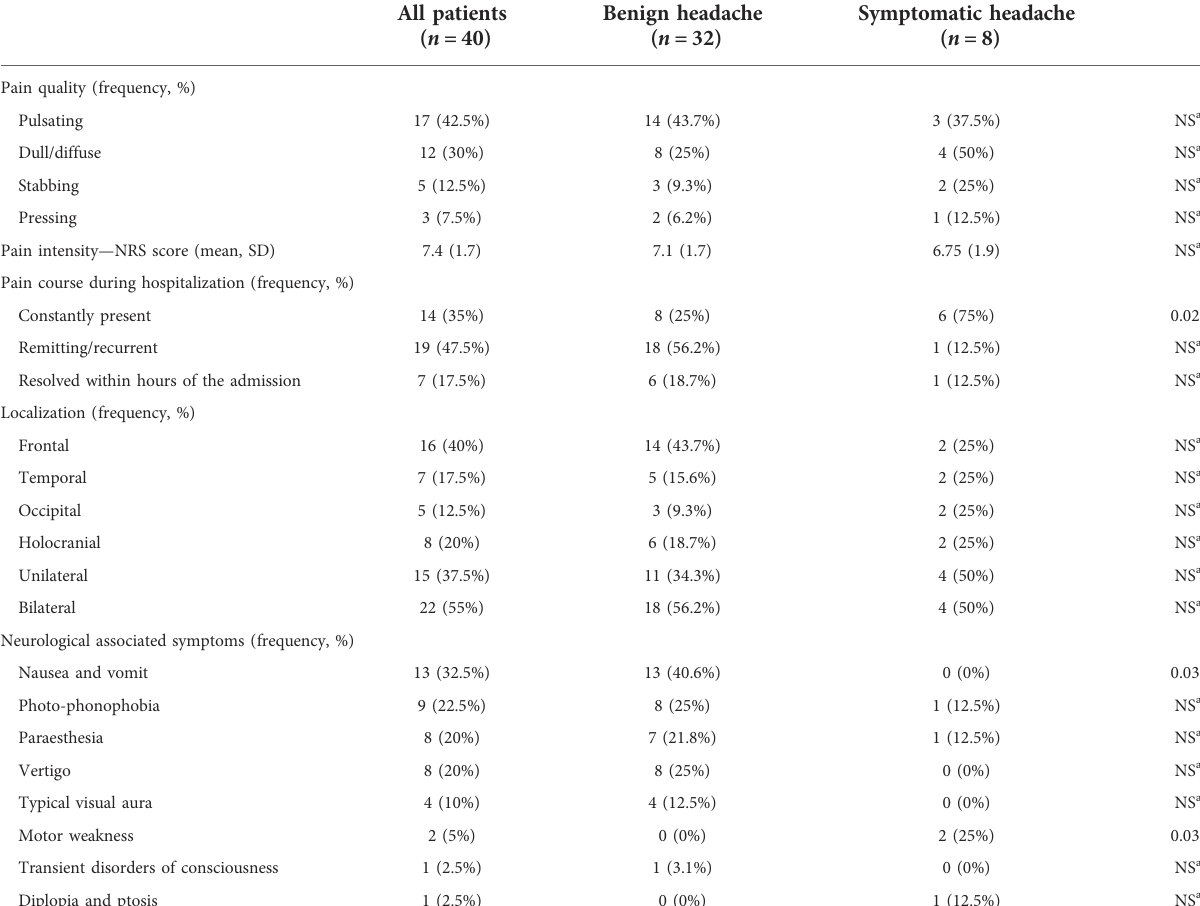
TABLE 2 Headache characteristics of all hospitalized